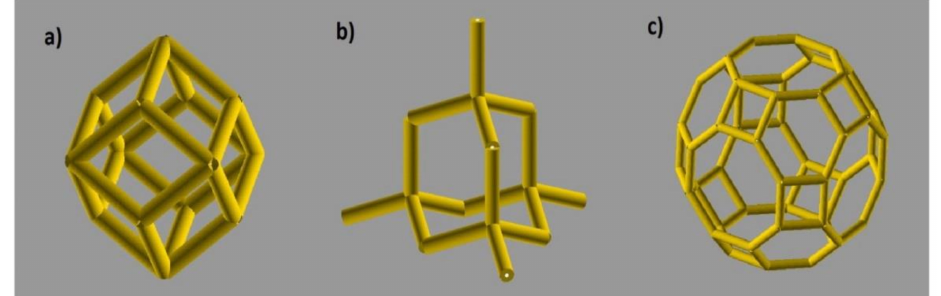
Figure 4. The geometry of ( a ) rhombic dodecahedron, ( b ) diamond, and ( c ) truncated cuboctahedron structures. Reprinted with permission from ref. [57]. 2015,